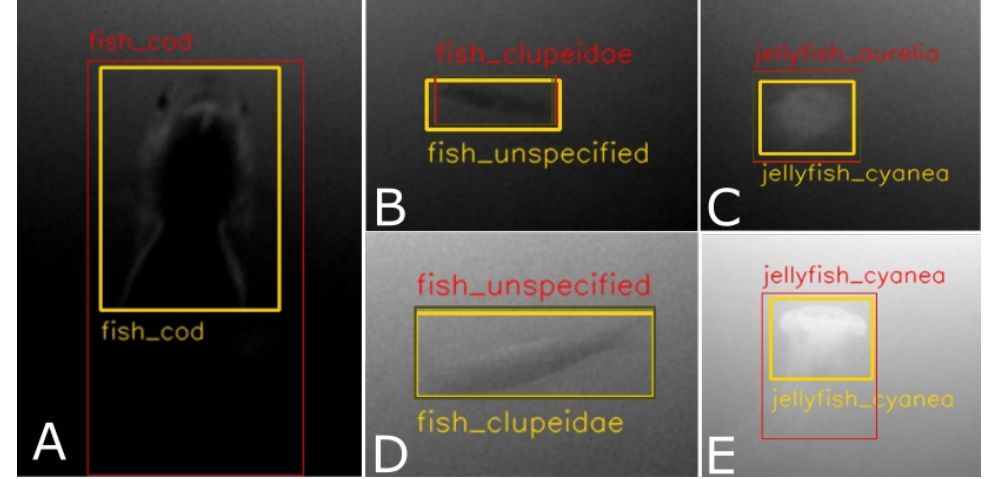
Figure 10. Examples of incorrect detections. The images shown are cropped from the full video frames and are marked with yellow bounding boxes for the target and red bounding boxes for false positives, which either do not match the target with sufficient IoU (0.5) or have incorrect class labels. The examples shown in ( A , E ) were rejected due to insufficient IoU, despite correct class labels, while ( B – D ) were rejected due to the wrong classes being